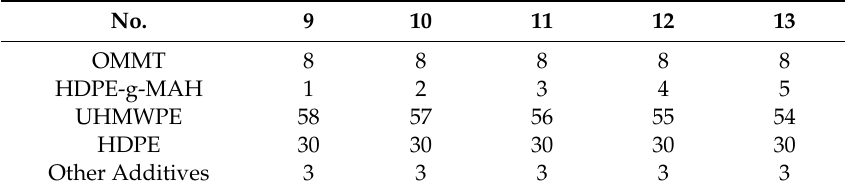
Table 4. Mass fraction of each component / %.